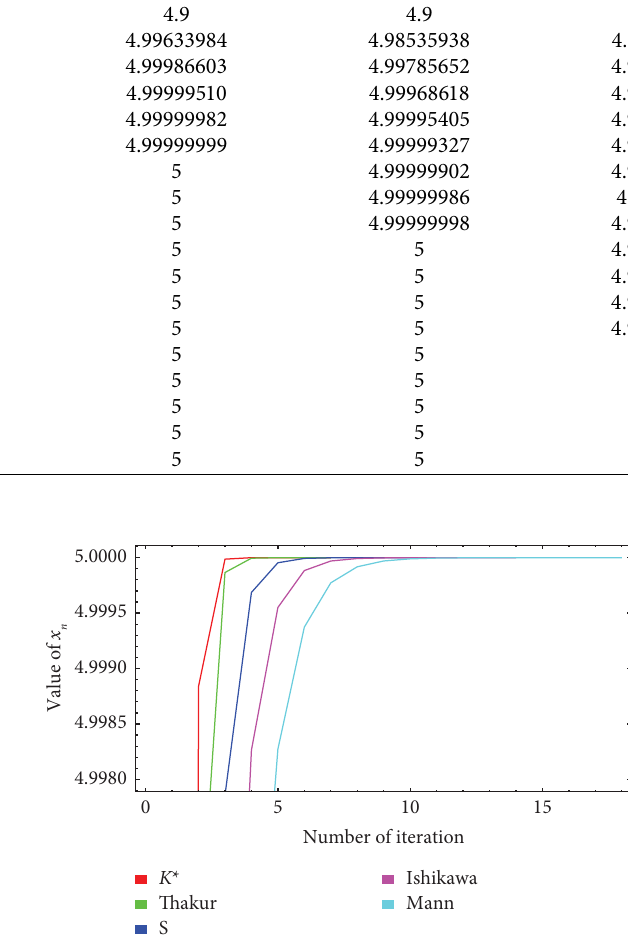
Figure 1: Graphical comparison of various iterative processes. Table 2: Comparison of the iterates for diferent choice of parameters and initial